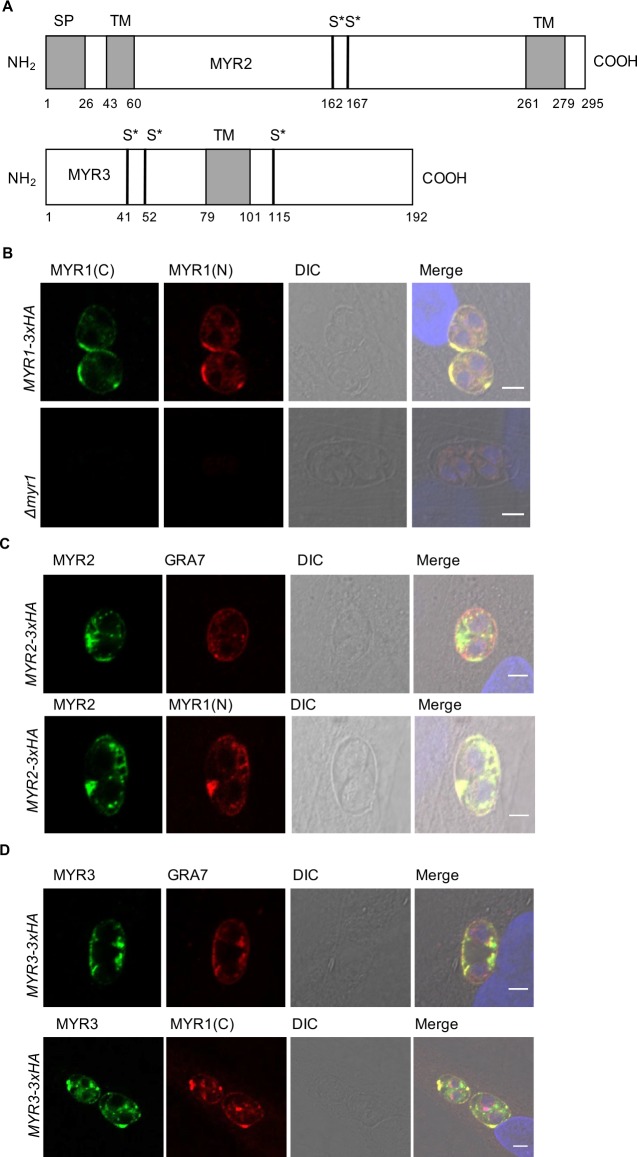
MYR1, MYR2, and MYR3 co-localize at the PV membrane and space.(A) MYR2 and MYR3 structure. Top: Schematic of MYR2 protein sequence with predicted signal peptide (SP), transmembrane domains (TM), and previously determined phosphorylated serine residues (S*) indicated [37]. Bottom: Similarly annotated schematic of MYR3. (B) Localization of MYR1(C)- and (N)-terminal fragments. RH tachyzoites stably expressing an endogenously 3xHA-tagged MYR1(C)-terminus or deleted for the MYR1 gene (Δmyr1) were allowed to infect HFFs. At 12 hpi, infected monolayers were fixed with methanol. The MYR1(C)-terminus was stained with anti-HA antibodies, the MYR1 (N)-terminus was stained with antibodies to a recombinant, N-terminal fragment of MYR1, and their localization was assessed using confocal microscopy. Host nuclei were stained with DAPI and differential interference contrast (DIC) microscopy was used to visualize the monolayer. Scale bar is 5 μm. (C) MYR2 localization. RHΔmyr2 tachyzoites were transiently transfected with a construct that expresses 3xHA-tagged MYR2 off the GRA1 promoter. Infected monolayers were fixed at 12–16 hpi with methanol. MYR2-3xHA was stained with anti-HA antibodies, and GRA7 and MYR1(C) were stained with antibodies to the corresponding recombinant proteins. All else as in (B). (D) MYR3 localization. Monolayers were infected with RH tachyzoites stably expressing 3xHA-tagged MYR3, fixed at 12–16 hpi with methanol, and stained as in (B).